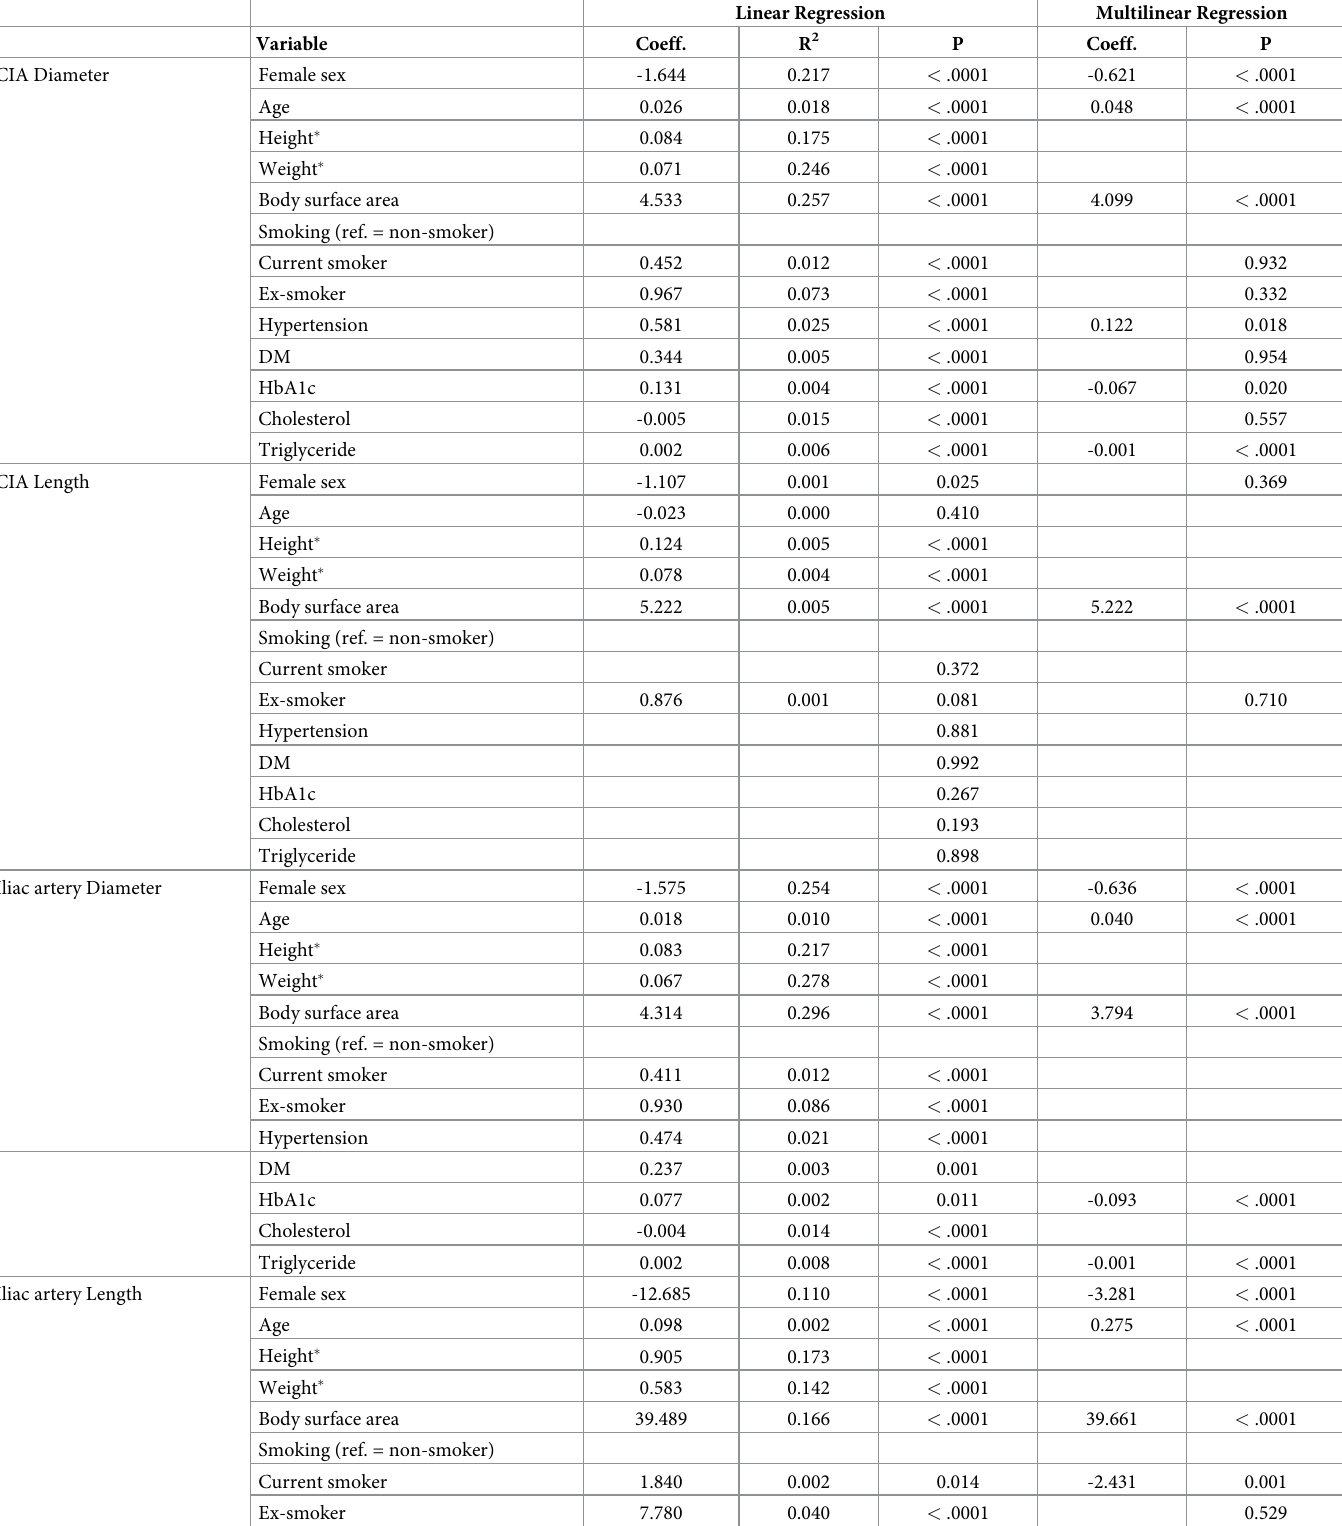
Table 4. Linear and multilinear regression of Common Iliac Artery (CIA) and iliac artery (common iliac to external iliac artery) diameters and lengths with variables.